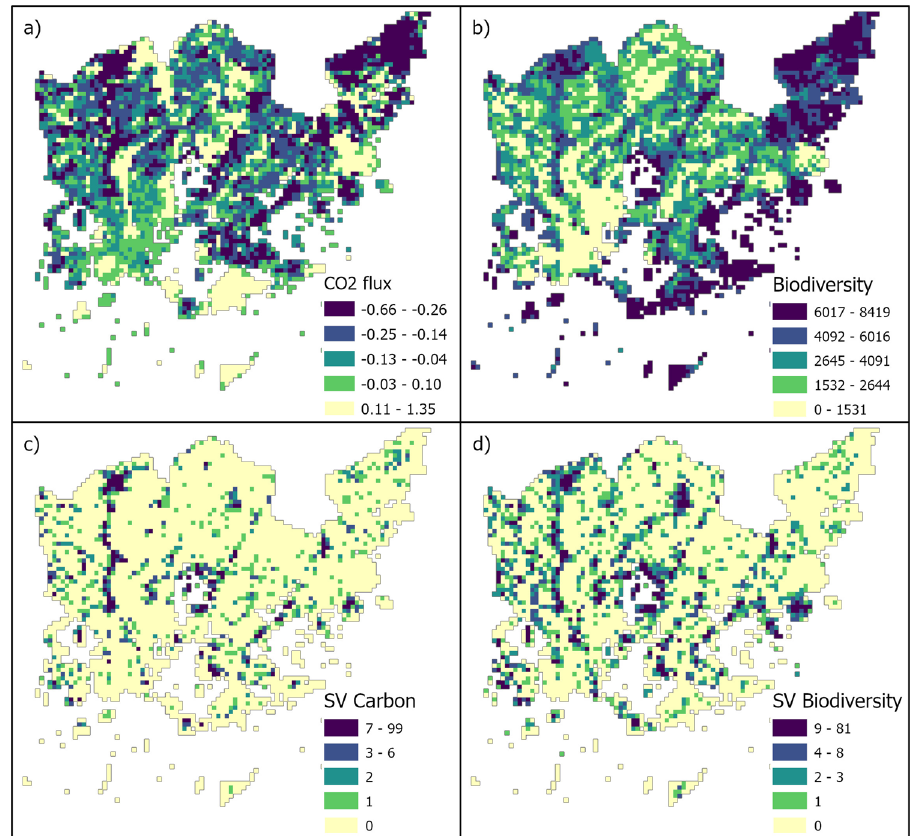
Fig. 2 Spatial distribution of biophysical and social values for carbon and biodiversity. Base layers for a CO 2 fl ux (kg C m − 2 year − 1 ) where negative values indicate a carbon sink and positive values are sources, b Biodiversity, c SV for Carbon represented by the number of records, d SV for Biodiversity. Graduate colour schemes scaled by quantiles. Bivariate comparison between each layer can be found in Supplementary Fig.